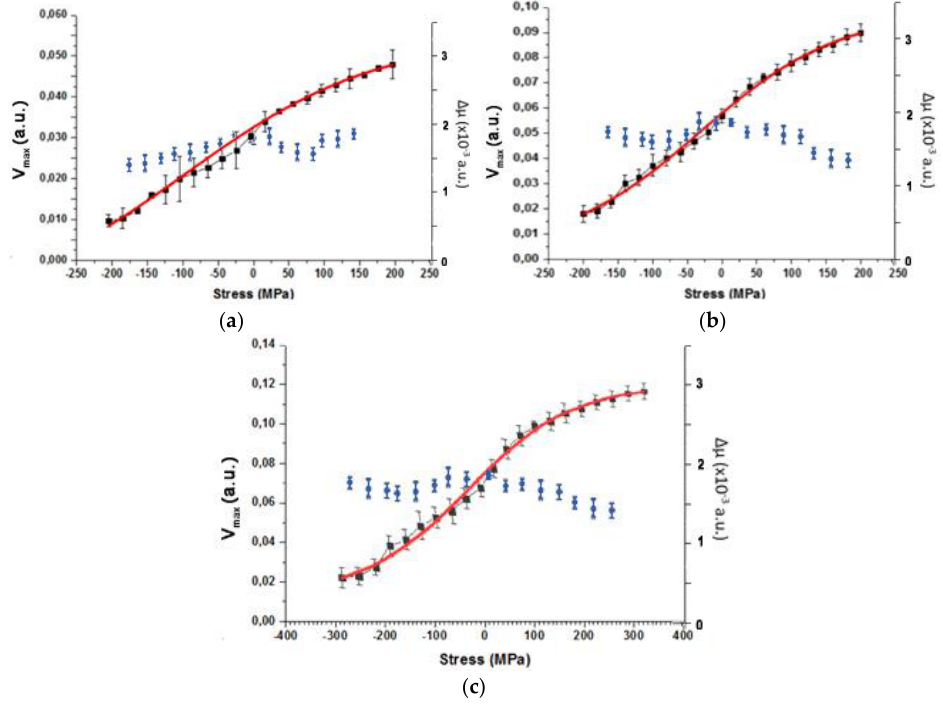
Figure 9. MASC curves obtained at the laboratory are compared against the difference ∆ µ (blue marks) between permeability measured on unwelded samples in the lab and permeability measured across GTAW welds for comparable levels of residual stress on samples of: ( a ) NOES, ( b ) AISI 1008 and ( c ) AISI 4130